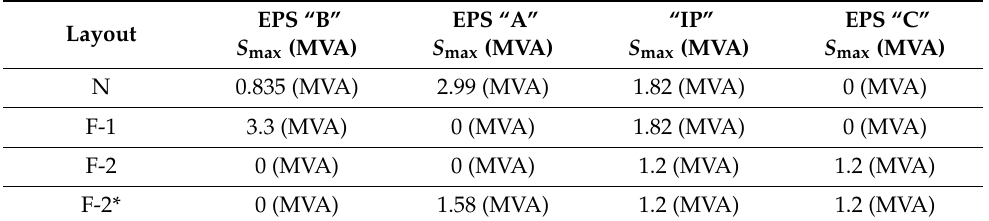
Table 15. Apparent power S at selected points in the network.